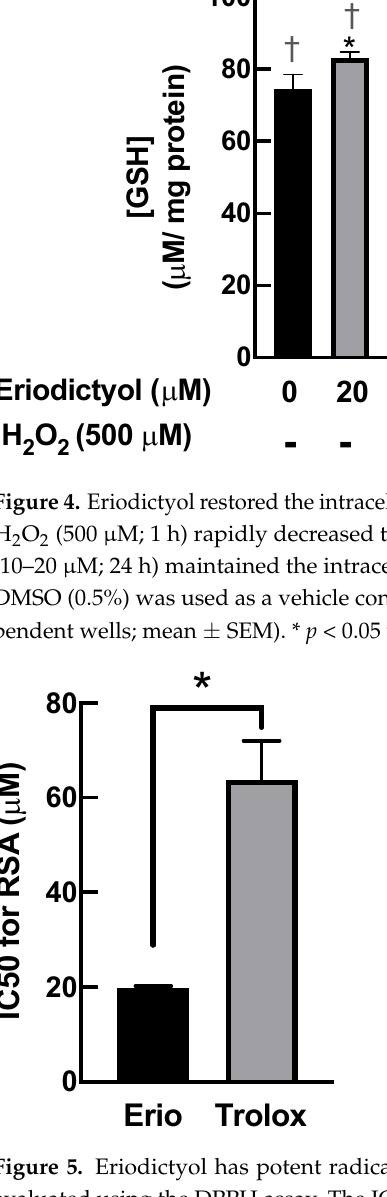
Figure 4. Eriodictyol restored the intracellular levels of reduced glutathione following H 2 O 2 expo- sure. H 2 O 2 (500 µM; 1 h) rapidly decreased the availability of GSH in BJ cells. Eriodictyol pretreat- ment (10–20 µM; 24 h) maintained the intracellular levels of GSH in a concentration-dependent fashion. DMSO (0.5%) was used as a vehicle control ( n = 3; each biological replicate consisted of three independent wells; mean ± SEM). * p < 0.05 versus vehicle controls; † p < 0.05 versus H 2 O 2 - treated cells.